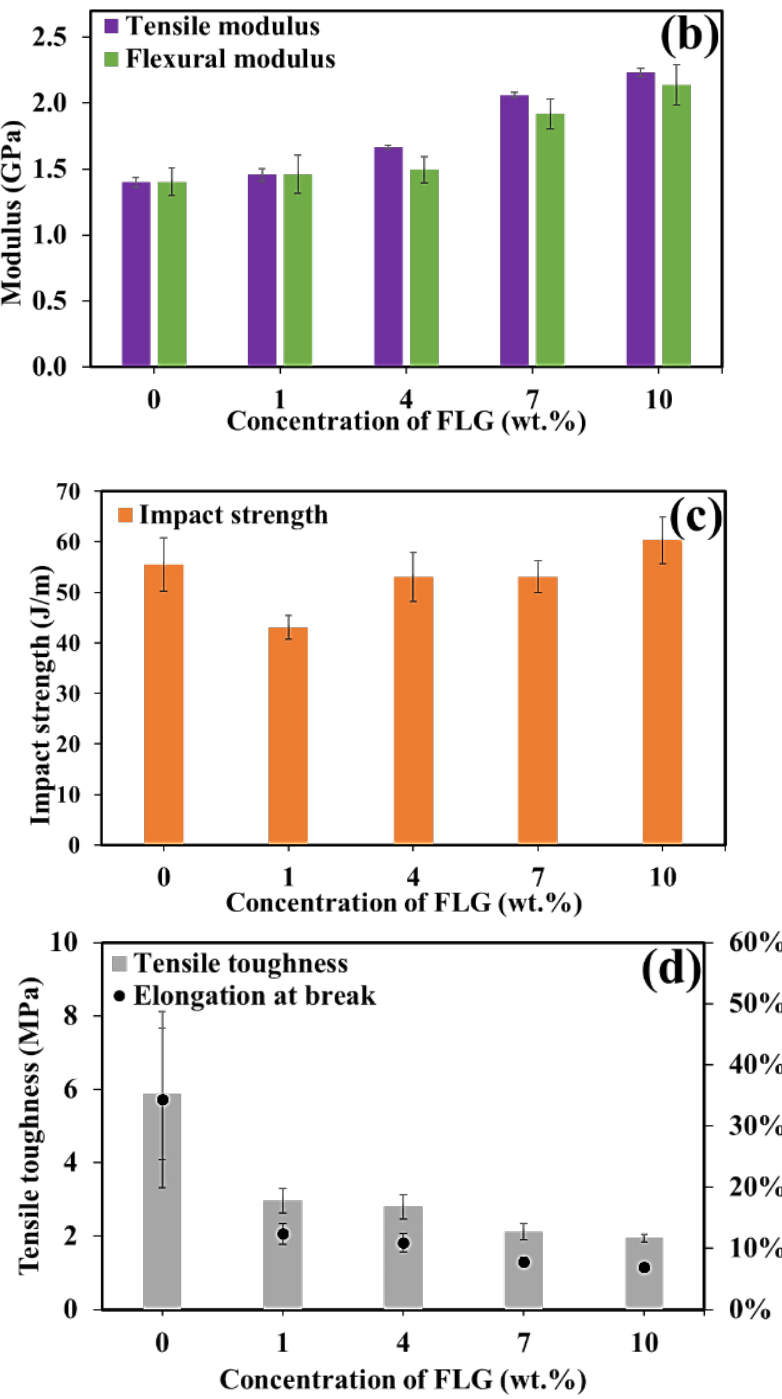
Figure 2. ( a )Tensile strength and flexural strength, ( b ) tensile modulus and flexural modulus and ( c ) impact strength, and ( d ) tensile toughness and elongation at break of the R-(PE/PP)/FLG compo- sites as a function of FLG concentration.